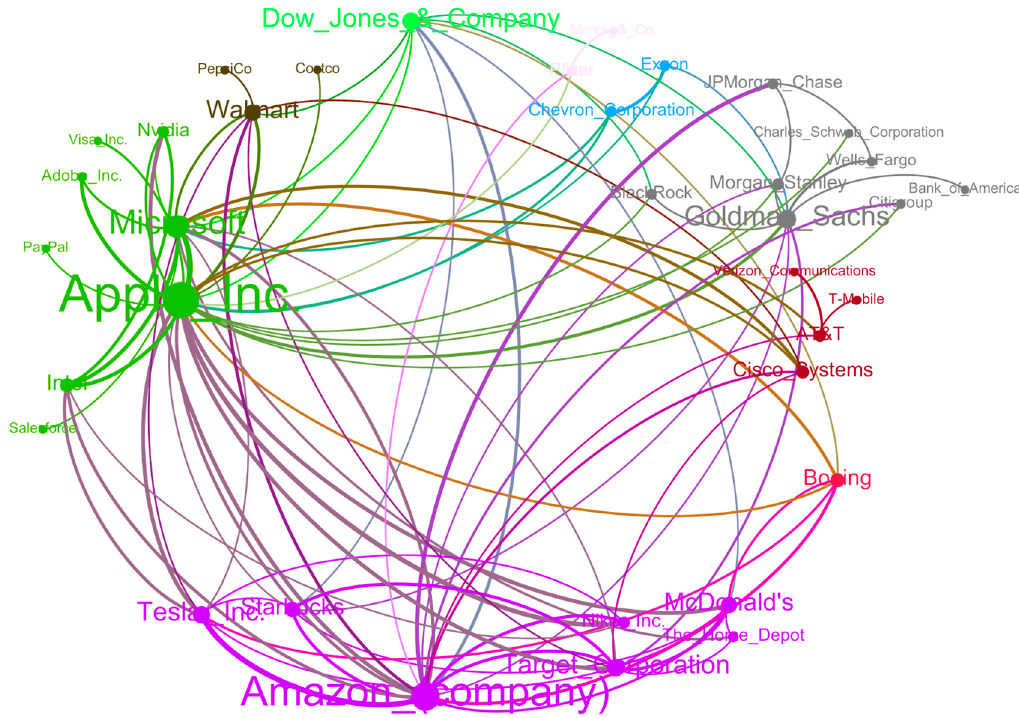
Figure 4. News co ‐ occurrence graph. Figure 4. News co-occurrence